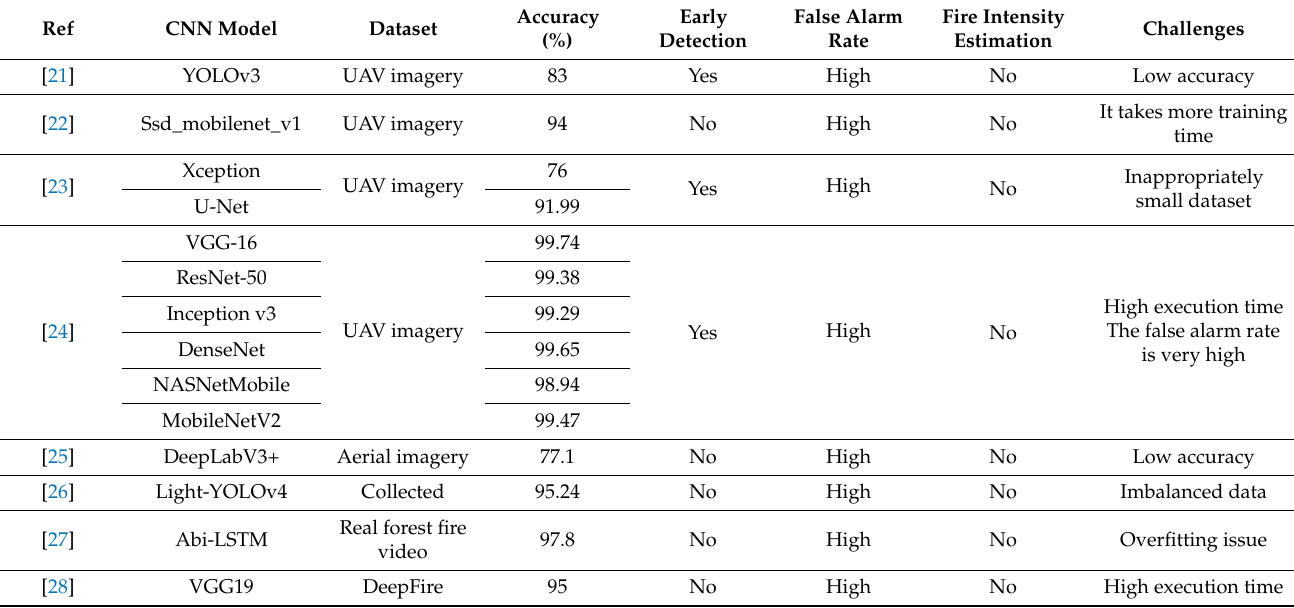
Table 1. Existing literature on deep-learning-based forest fire